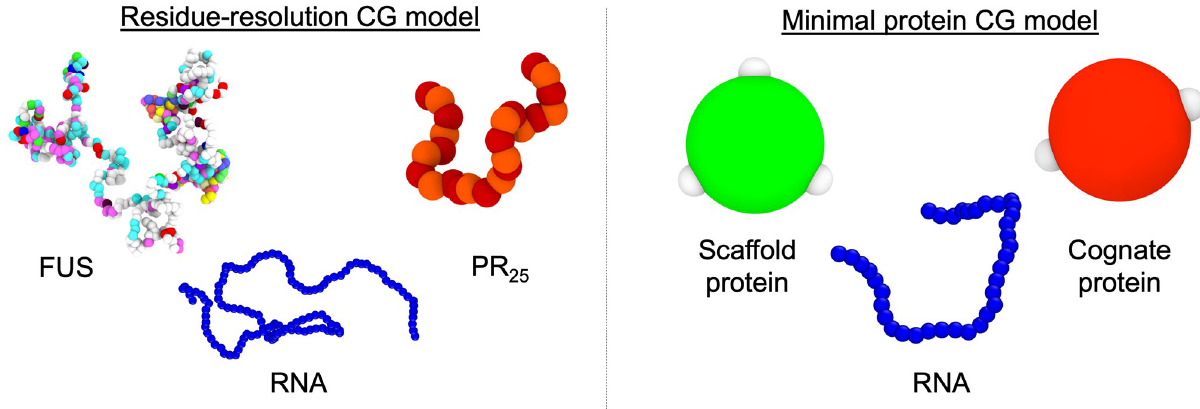
Fig 1. Coarse-grained models used to investigate phase separation of RBP–RNA mixtures. Left: Residue-resolution sequence-dependent coarse- grained representation of full FUS, PR 25 , and a 400-mer polyU RNA strand, using the Mpipi model [57]. The Mpipi model represents each amino acid and nucleotide by a single bead and describes the solvent implicitly. Please note that the size of the beads represented in this panel have been conviniently rescaled for visualization purposes. Globular protein domains are modelled as rigid bodies based on the crystal structure of the folded domains, whereas disordered protein regions and RNA are treated as fully flexible polymers. Coloured beads indicate distinct types of residues/ nucleotides. Right: Minimal model for scaffold proteins, cognate proteins, and RNA, as done previously [69, 91, 120]. White patches represent protein binding sites, while green and red spheres account for the excluded volume of the scaffold and cognate proteins, respectively [91]. RNA is modelled as a self-repulsive flexible polymer of (pseudo) hard-spheres [69]. Please note that the real size of the RNA beads has been intentionally reduced in this image to facilitate its visualization; in the simulations, the size of each RNA bead is the same as the central pseudo hard-sphere of the proteins.